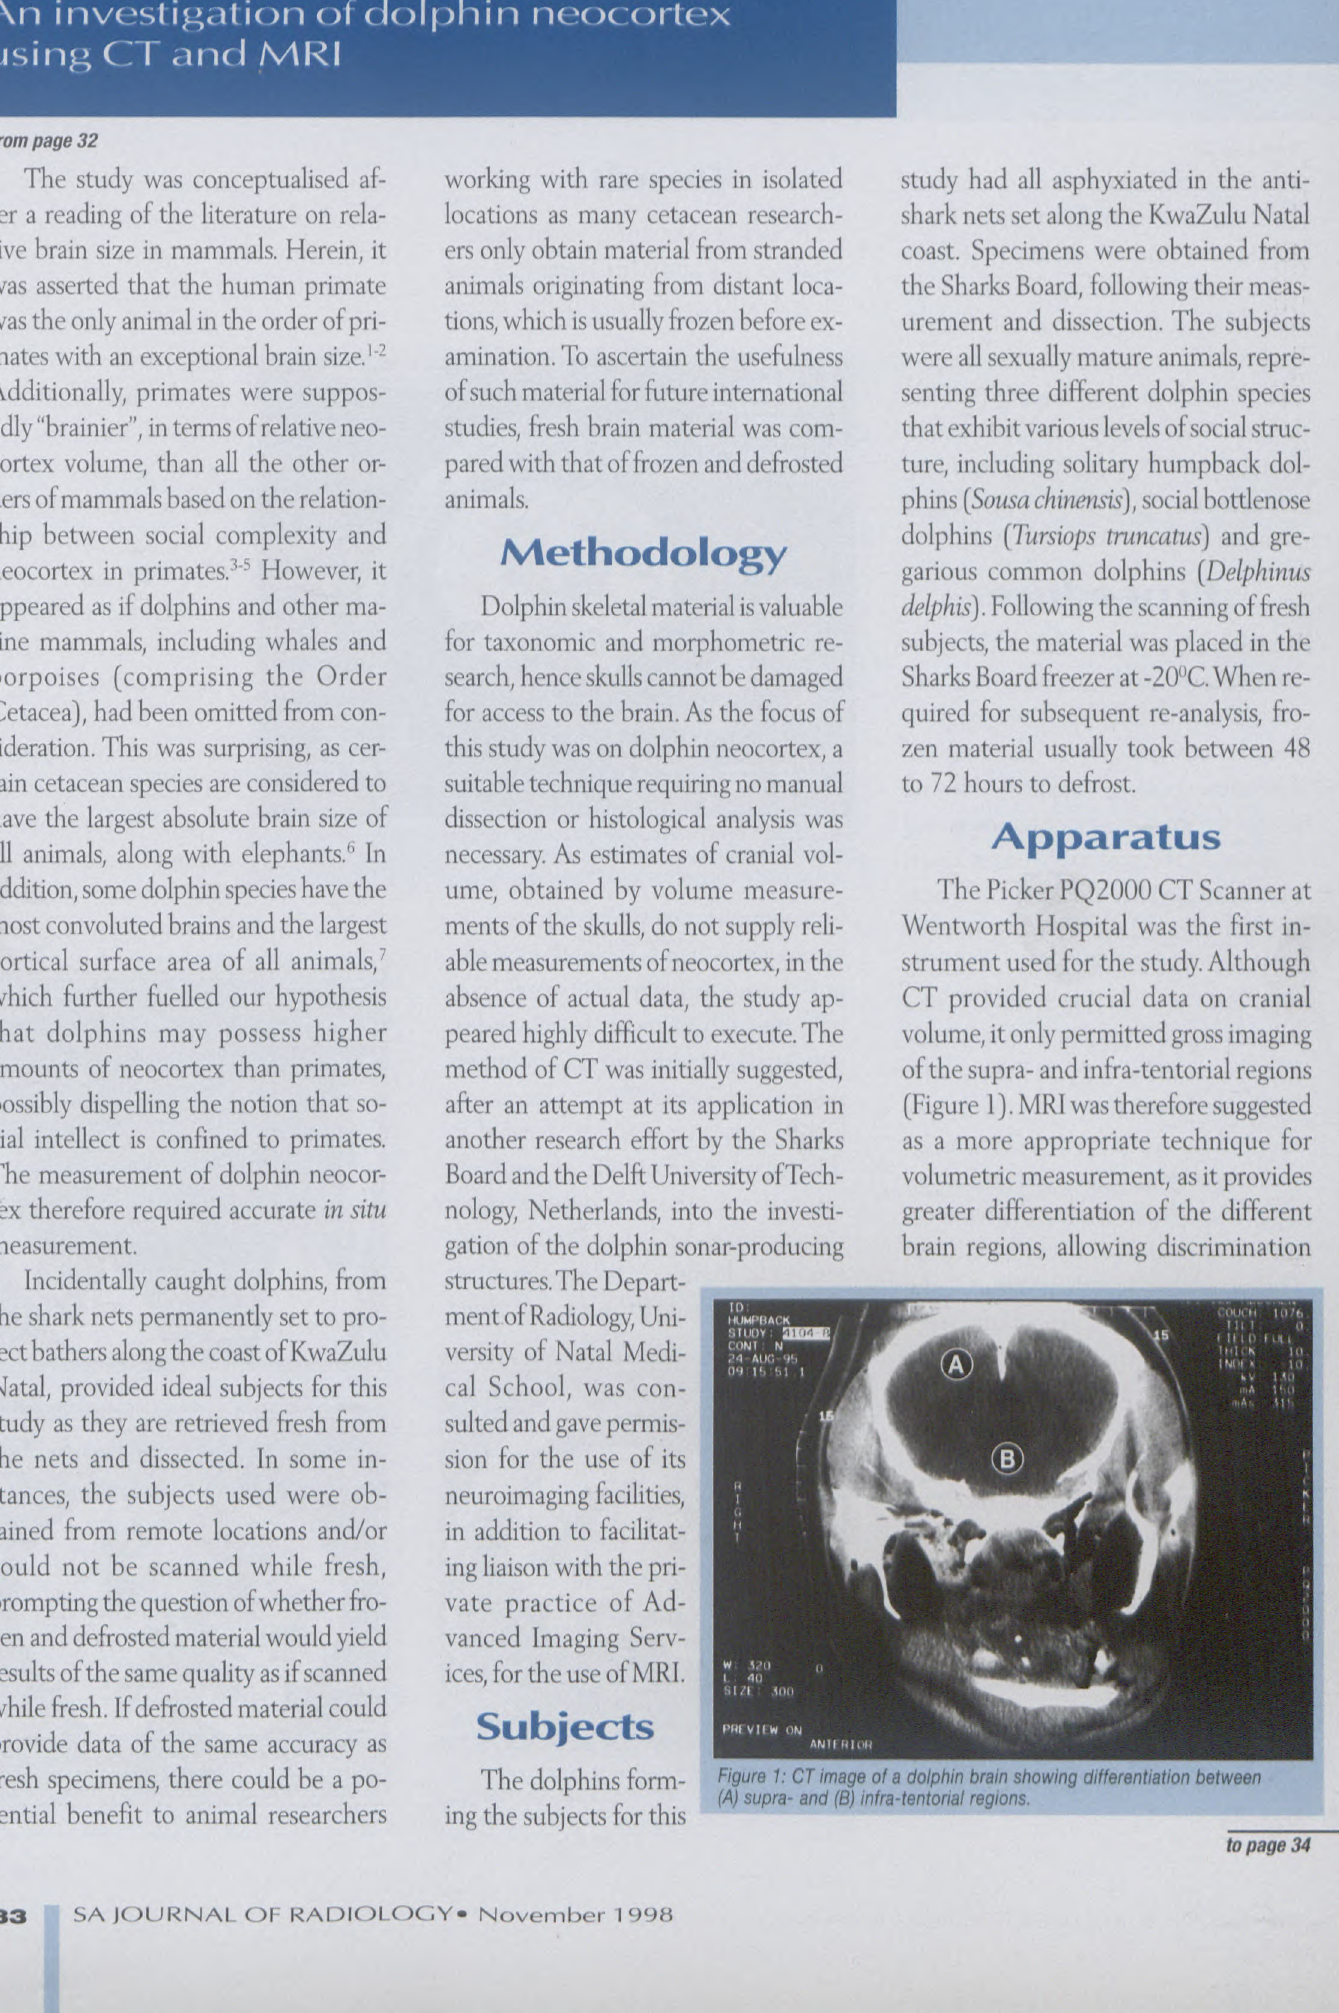
Figure 1: CT image of a dolphin brain showing differentiation between (A) supra- and (B) infra-tentorial regions.